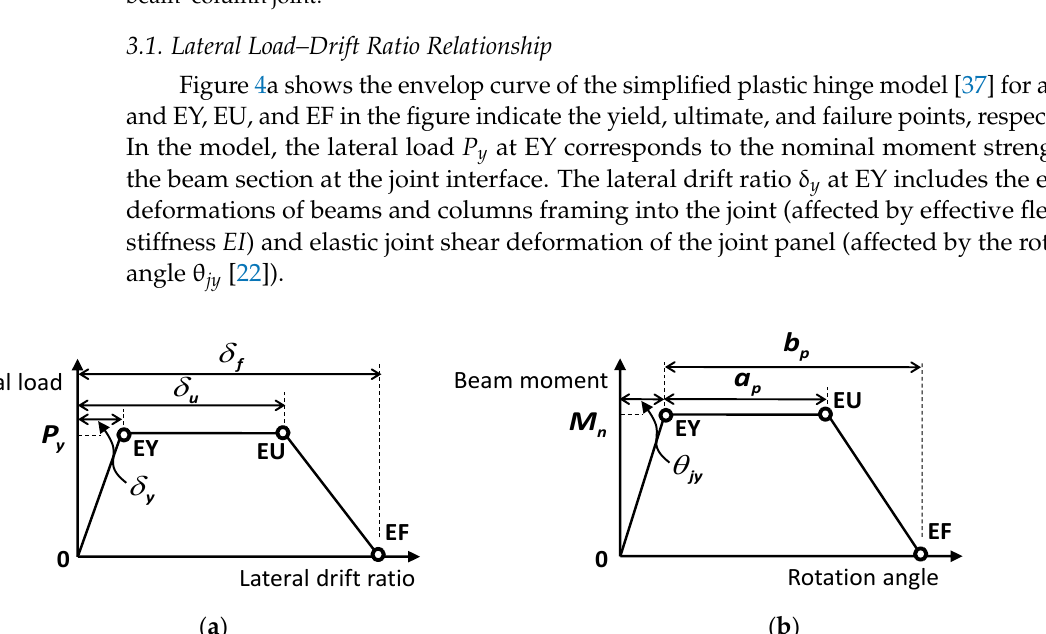
Figure 3. Plastic hinge model for beam–column joints: ( a ) interior beam–column joint; ( b ) exterior beam–column joint.